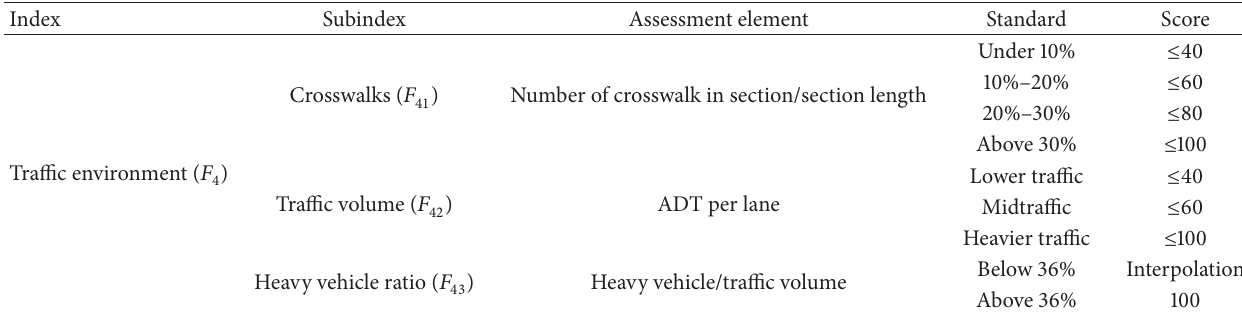
Table 14: Calculation and scoring method according to assessment items.